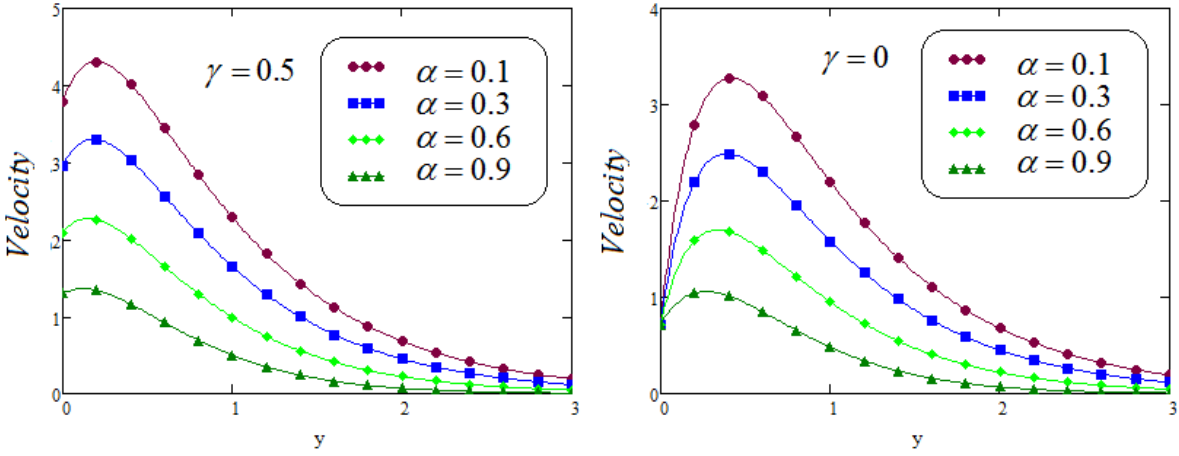
Figure 16. Velocity for varied values of α with and without slip effect γ when f ( t ) = sint , t = 1.5, β = 0.3, Gr = 3.5, λ 1 = 0.6, λ 2 = 0.2, M = 2, P r =